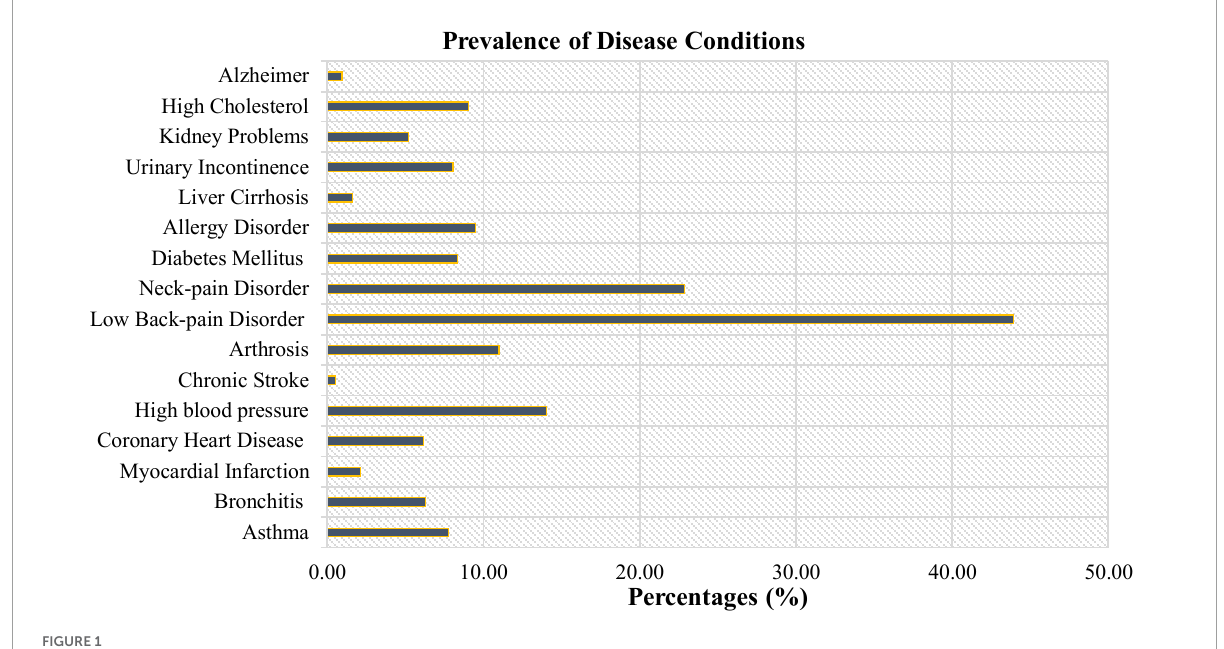
FIGURE1 Prevalence of the different types of disease condition among the study participants.